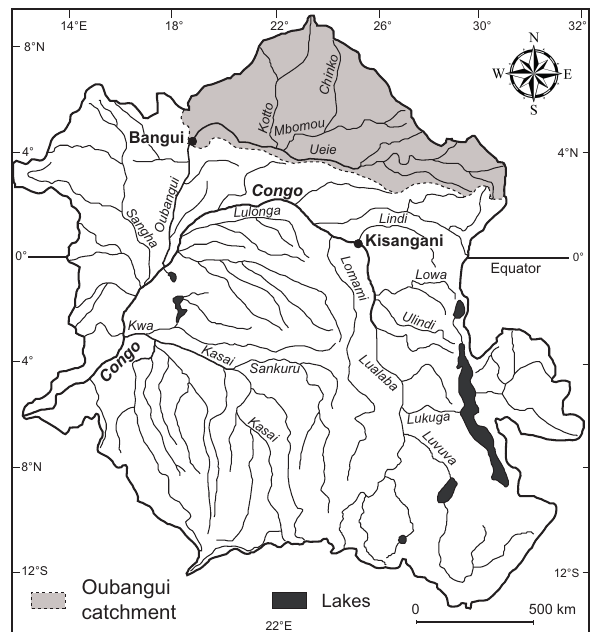
Fig. 1. Overview map of the Congo River drainage network, with indication of the sampling location and the extent of the Oubangui catchment upstream of the sampling site. Modified after Runge and Nguimalet